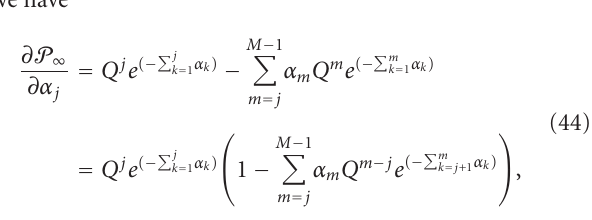
From (7) for n > 1, we